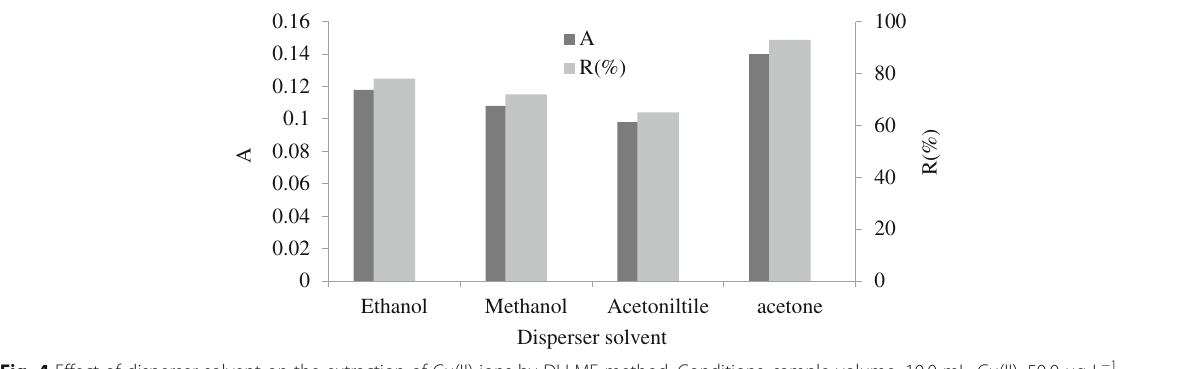
Fig. 4 Effect of disperser solvent on the extraction of Cu(II) ions by DLLME method. Conditions: sample volume, 10.0 mL; Cu(II), 50.0 μ g L − 1 , solution pH = 2.0; salophen, 2.0 × 10 − 5 M; disperser solvent (acetone) volume, 1.30 mL; diluting solvent (ethanol) volume, 120 μ L; centrifuge